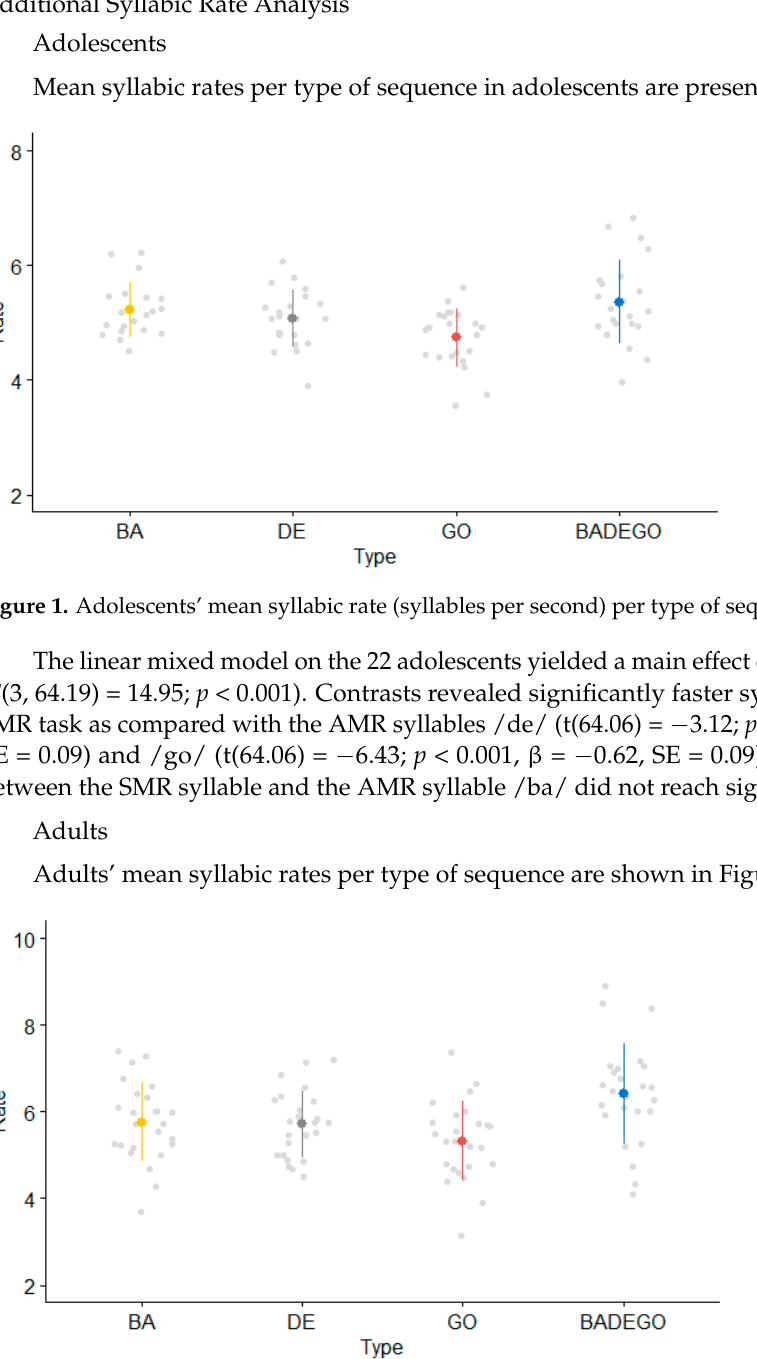
Figure 2. Adults’ mean syllabic rate (syllables per second) per type of sequence. The linear mixed model on the adult data indicated a main effect of type of sequence (F(3, 73.82) = 19.34; p < 0.001). Contrasts revealed significantly faster syllabic rates for the SMR task as compared with all the AMR syllables: /ba/ (t(73.76) = − 4.44; p < 0.001, β = − 0.65, SE = 0.15), /de/ (t(73.88) = − 5.15; p < 0.003, β = − 0.77, SE = 0.15) and /go/ (t(73.76) = − 7.42; p < 0.001, β = − 1.09, SE =